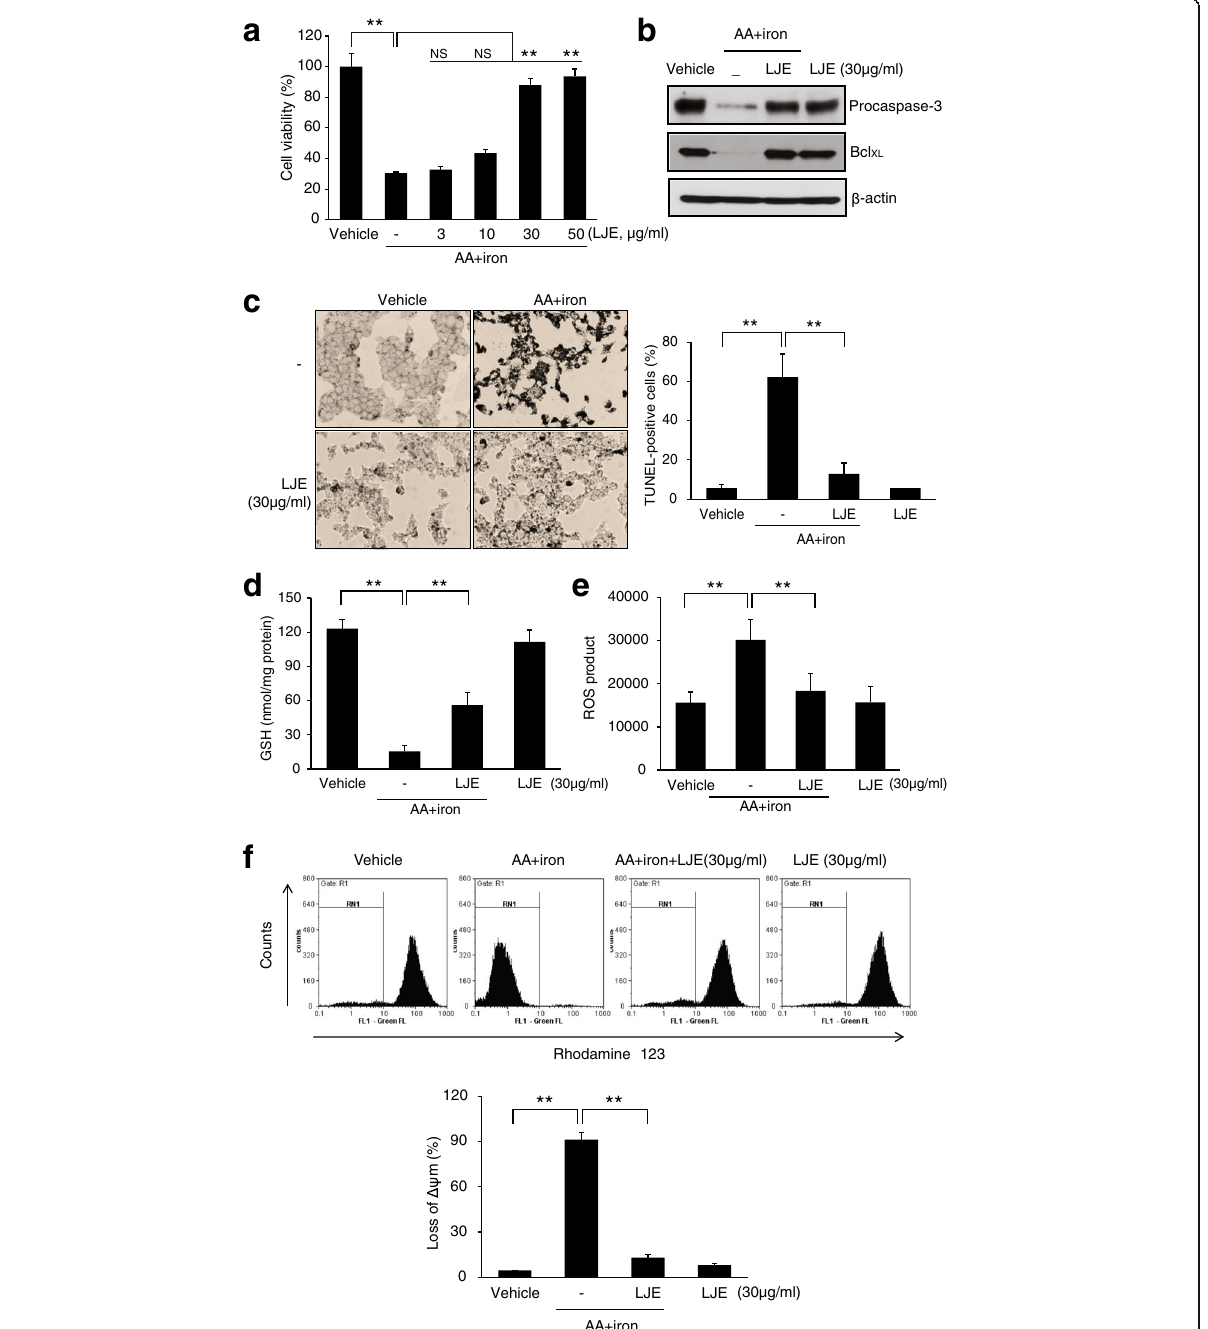
Fig. 1 L. japonica extract (LJE) decreases AA + iron induced cytotoxicity in HepG2 cells. HepG2 cells were incubated with indicated dose of LJE for 1 h and later treated with 10 μ M AA for 12 h, being followed by exposure to 5 μ M iron for 3 h. ( a ) Cell viability was assessed by the MTT assay. ( b ) Expression of proteins associated with apoptosis was determined by western blot analysis. Equal protein loading was verified by β -actin. ( c ) The levels of apoptosis in each groups examined by TUNEL assay. Representative images show apoptosis of HepG2 cells in vehicle control, LJE treated, AA + iron treated, and AA + iron treated with LJE groups (left). Percentage of TUNEL+ cell nuclei calculated relative to total number of cell nuclei (right). ( d ) Cellular GSH content was assessed in cells by using GSH assay kit. ( e ) Cellular reactive oxygen species production was moni- tored by measuring intensity of dichloro fluoresce in fluorescence. ( f ) ΔΨ m depolarization monitored by FACS analysis of Rh123 staining. Relative proportions of low Rh-123 intensity (RN1 fractions) are expressed as the mean ± S.D. of three separated experiments. For panel from A to E, data represent the mean ± S.D. for the four replicates. ** p <